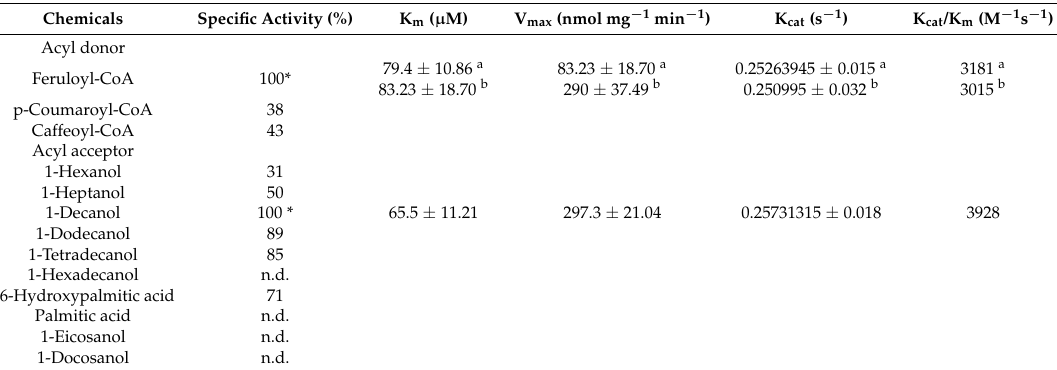
Table 1. Activity and Kinetics of Recombinant MeHFT on Different Acyl Donors and Acceptors.